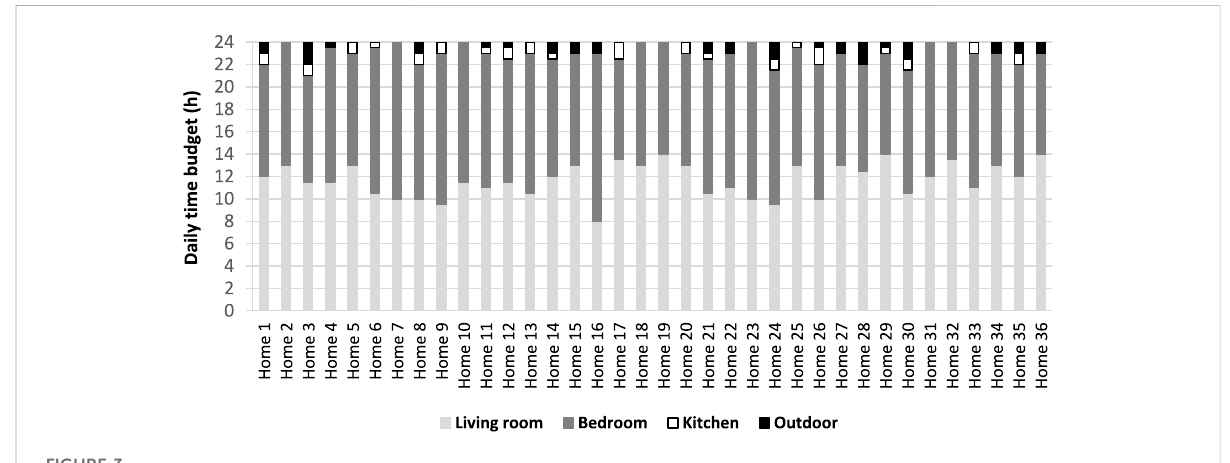
FIGURE 3 Time-budget per day of children for the microenvironments of each residence.